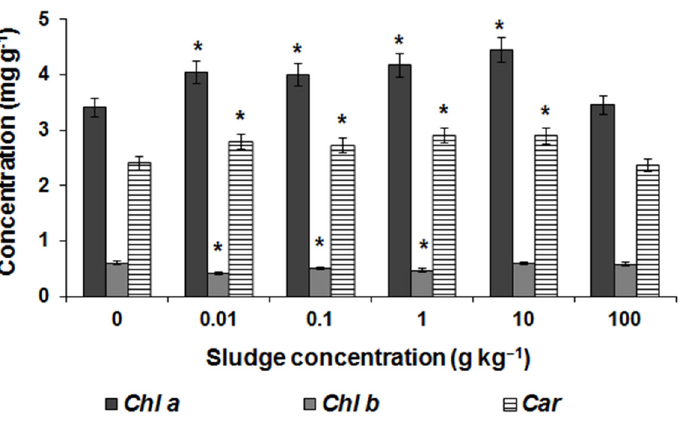
Figure 9. The content of pigments in rapeseed plants. *—significant differences with the control.